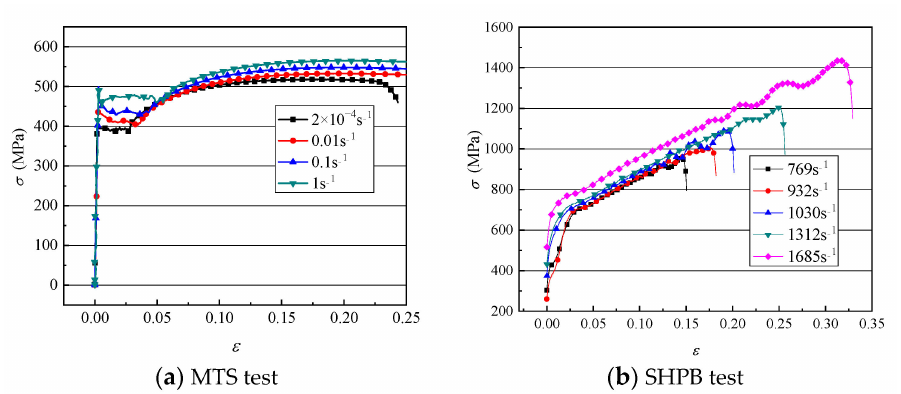
Figure 10. Stress–strain curves of EH36 at different strain rates, room